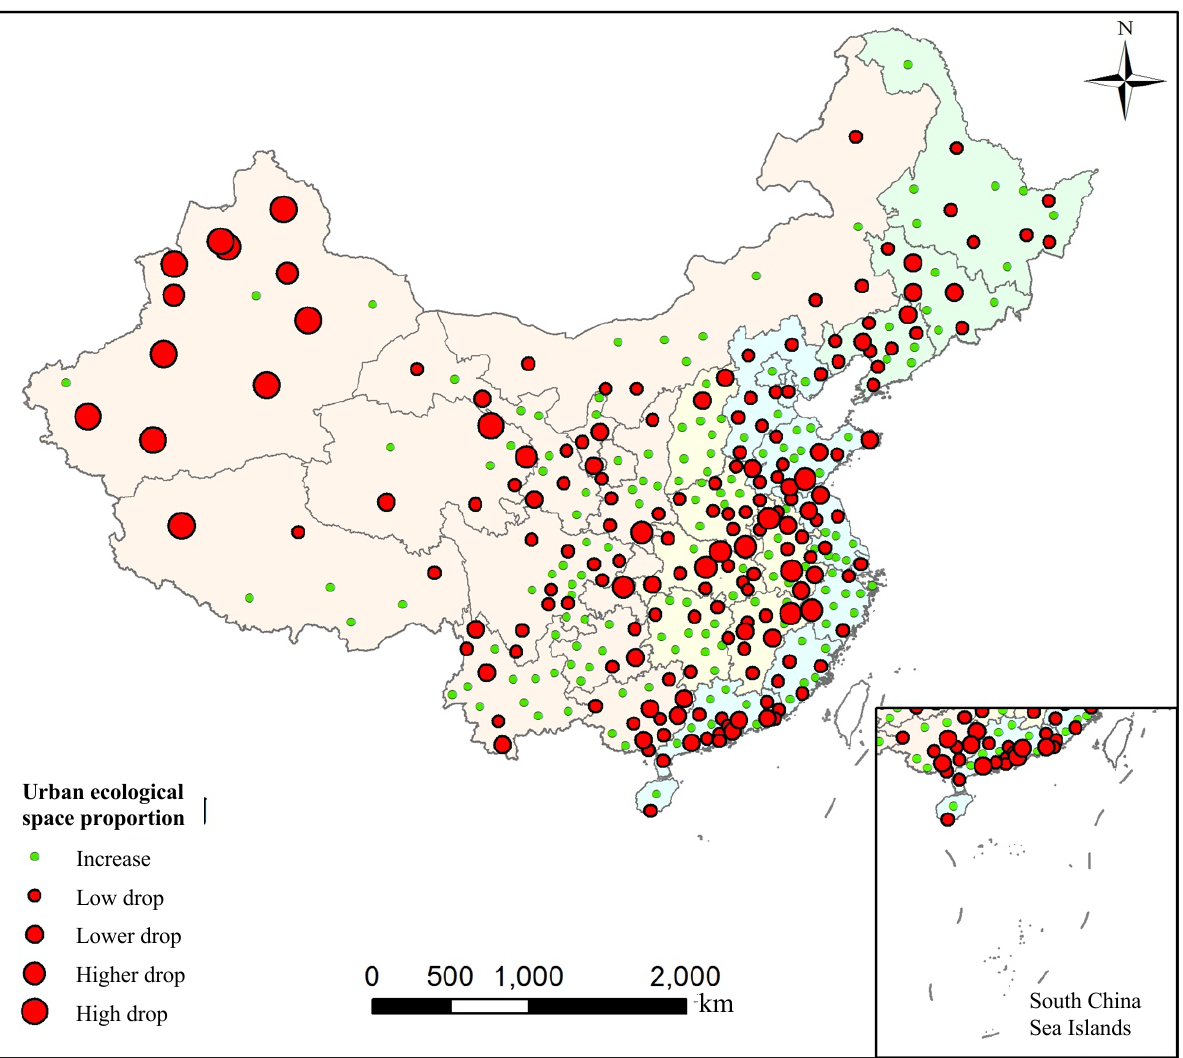
Figure 1. Hierarchical map of urban ecological space proportion change of 338 prefecture-level cities in China from 2016 to